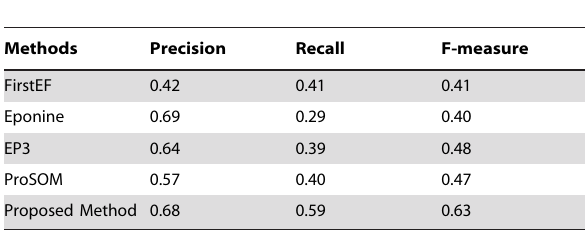
Table 6. Genome-wide promoter prediction performance comparison of different promoterprediction programs with maximum allowable distance of 500 bp from annotated